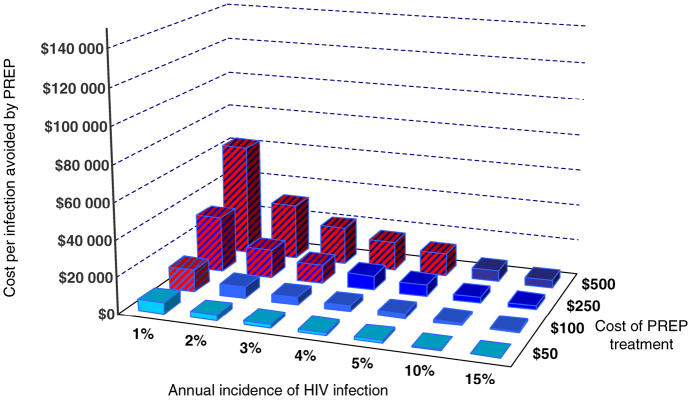
Cost-Effectiveness of PREP with an 80% Efficacy RateThis graph shows the cost per infection avoided by PREP (US$) by annual HIV incidence (%) and by cost of PREP treatment (US$), assuming PREP cuts incidence of HIV infection by 80%. The striped bars indicate that the cost per infection avoided by PREP was over $10,000 and was therefore not considered to be cost-effective.